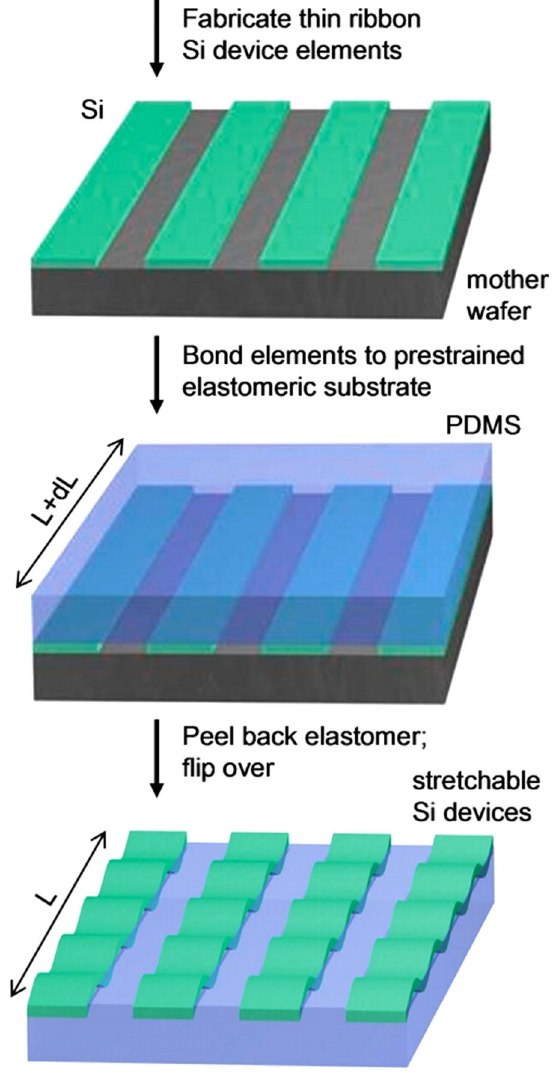
Fig. 1 Schematic illustration of the process for fabricating stretch- able single-crystal Si devices on elastomeric substrates. (reprinted with permission from ref. 12.)